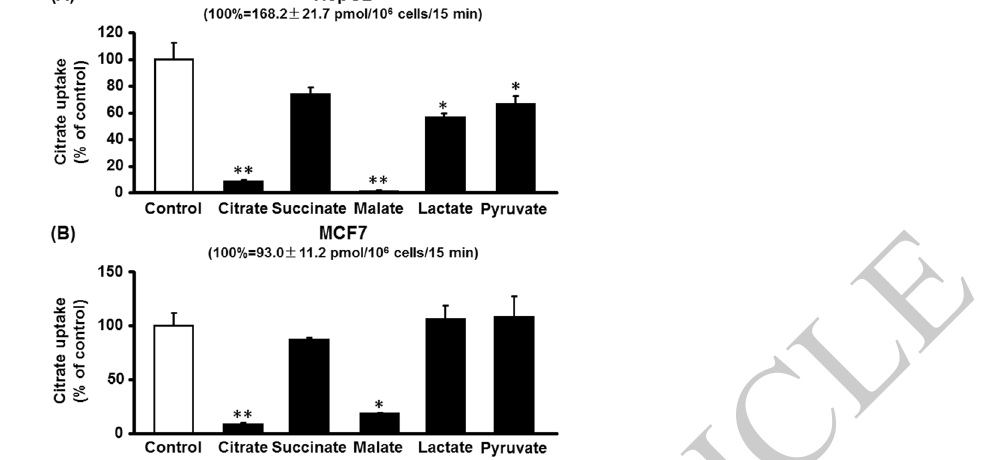
Figure 4. Substrate selectivity of the citrate transport system that is stimulated in HepG2 cells and MCF7 cells by Fe 3 + . HepG2 ( A ) and MCF7 cells ( B ) were cultured to confluence prior to uptake measurements. Uptake of [ 14 C]-citrate (3.5 μ M) was measured in NaCl buffer, pH 7.5, for 15 min in the presence of FeCl 3 (50 μ M) in absence or presence of the various carboxylates (2.5 mM). * p < 0.05; ** p <